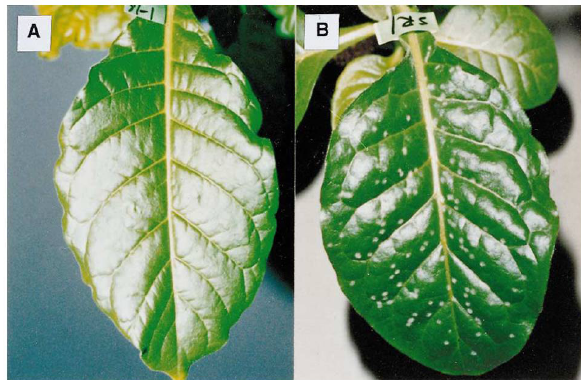
Fig. 2. Enhanced resistance of transgenic tobacco plants